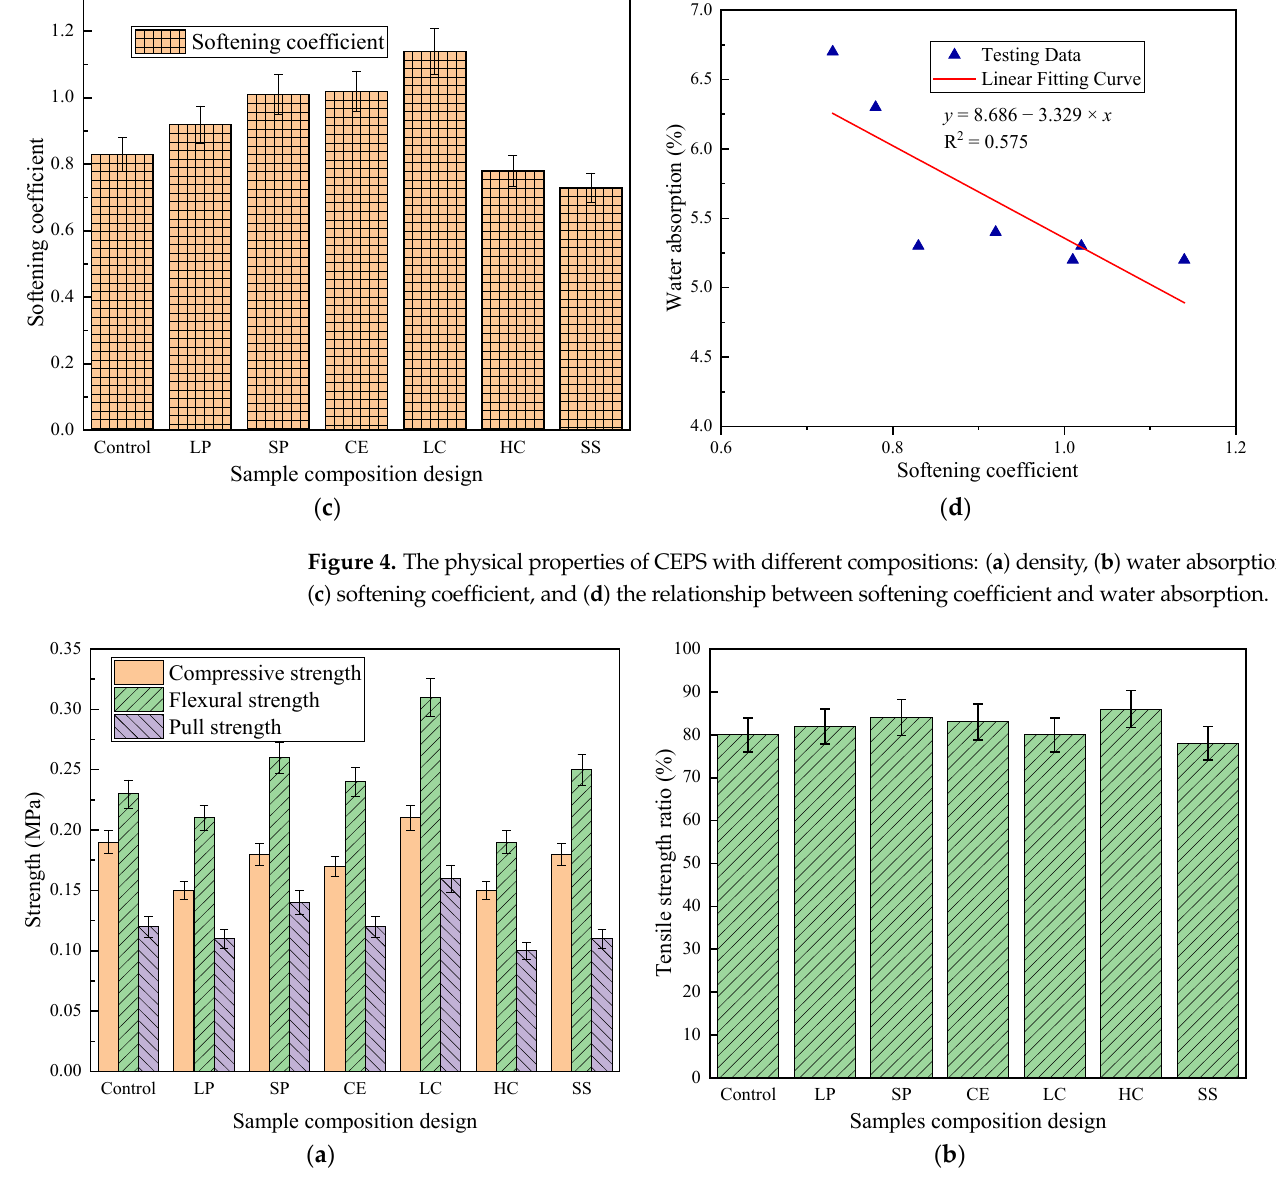
Figure 5. The strength and residual tensile strength ratio of seven CEPS groups: ( a ) strength and ( b ) tensile strength ratio.